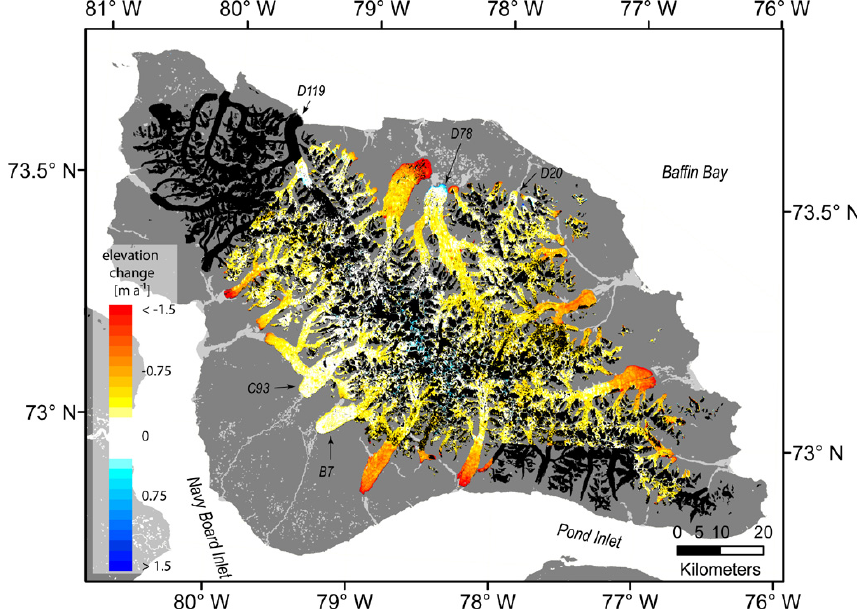
Fig. 4. Elevation change rate (ma − 1 ) of the glaciers of Bylot Island between 1979 and 2008 as determined from DEMs generated from airborne and SPOT-5 satellite stereoscopic imagery. Areas of black indicate no data.